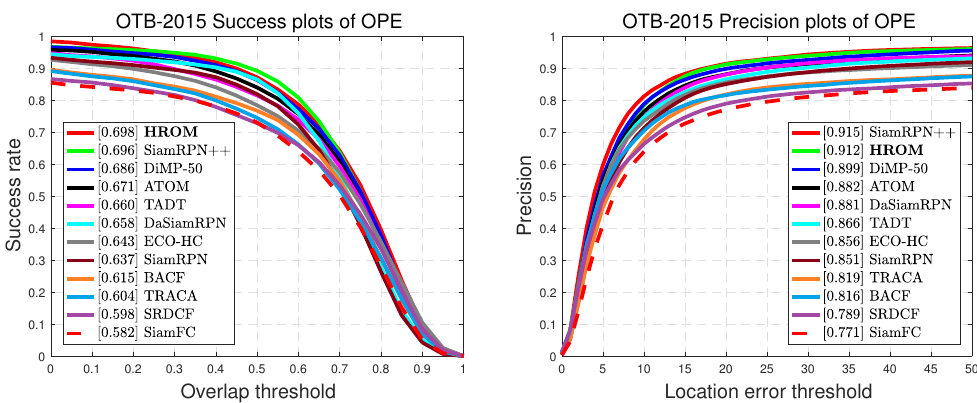
Figure 6. Success and precision plots on OTB-2015. The legend reports the area-under-the-curve scores of success plot and center-location-error at 20 pixel of precision plot for each